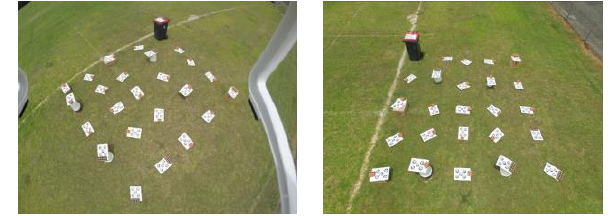
Figure 4. Field calibration: P1 (left) and P3 (right).